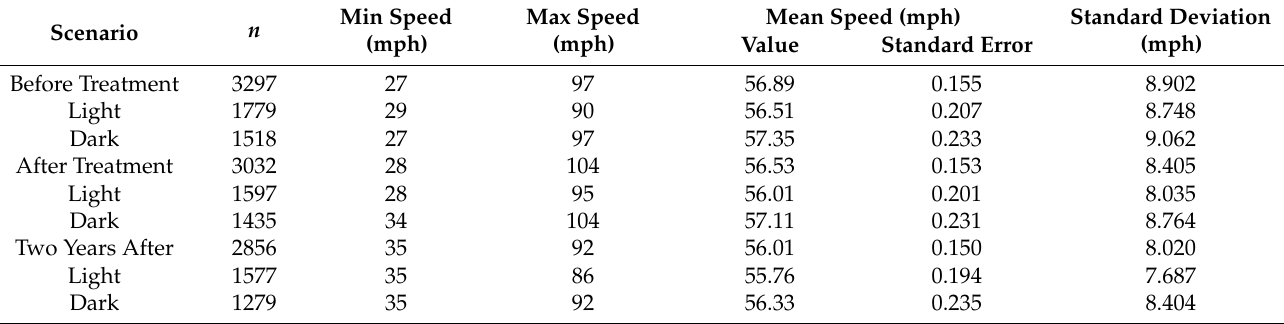
Table 1. Descriptive statistics by scenario and light conditions for